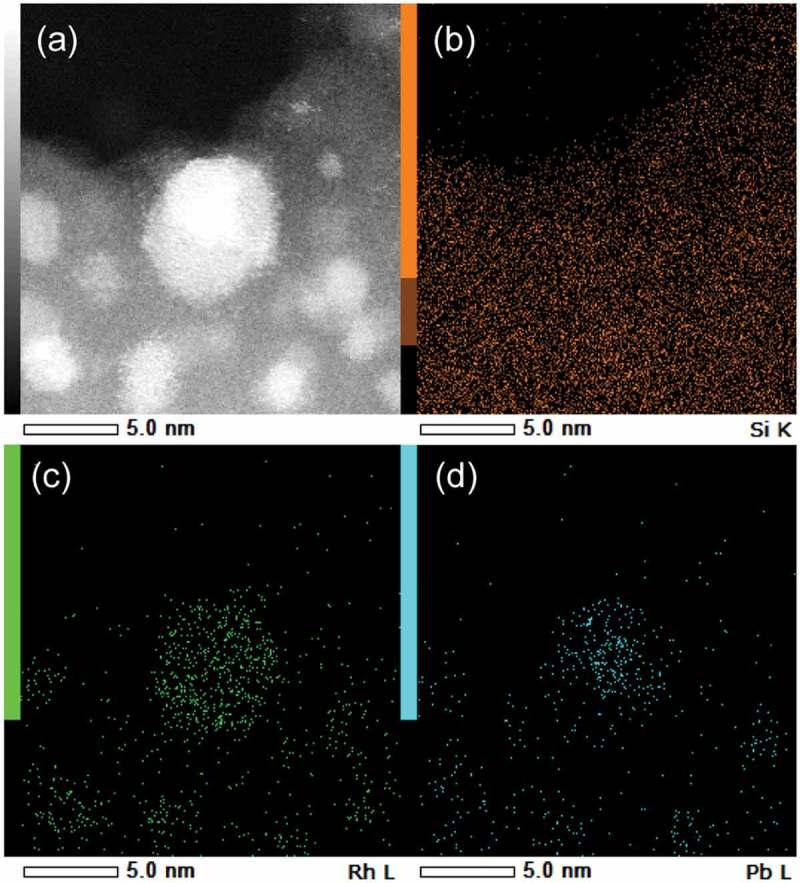
(a) HAADF-STEM image of RhPb2/SiO2 catalyst and the corresponding elemental maps of (b) Si, (c) Rh, and (d) Pb acquired using EDX.